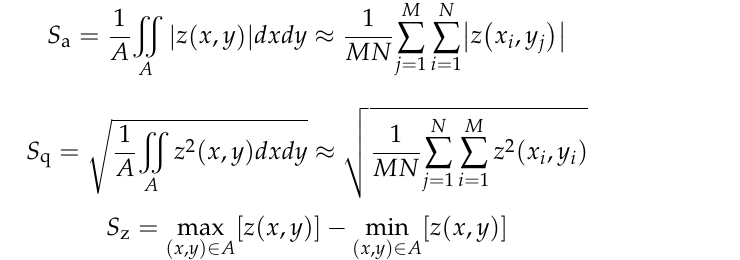
Table 1. Results summary of surface profile measurements and stress concentrations analysis of the unpatched corroded steel